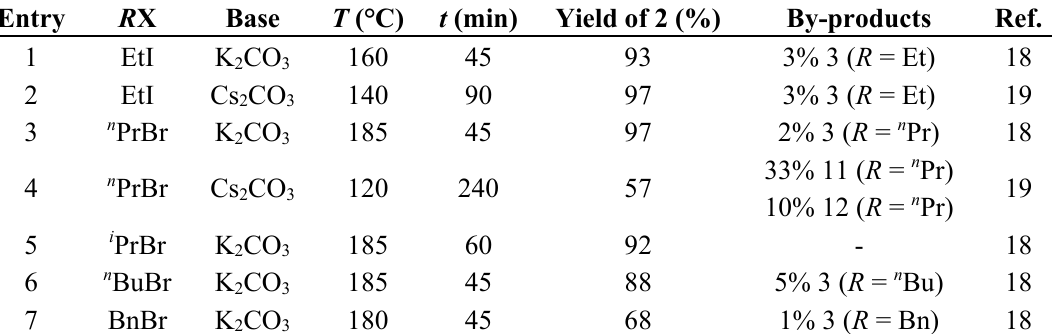
1. Alkylation of diethyl malonate ( 1 ) under microwave (MW) and solvent-free conditions. Yield of 2 (%) By-products